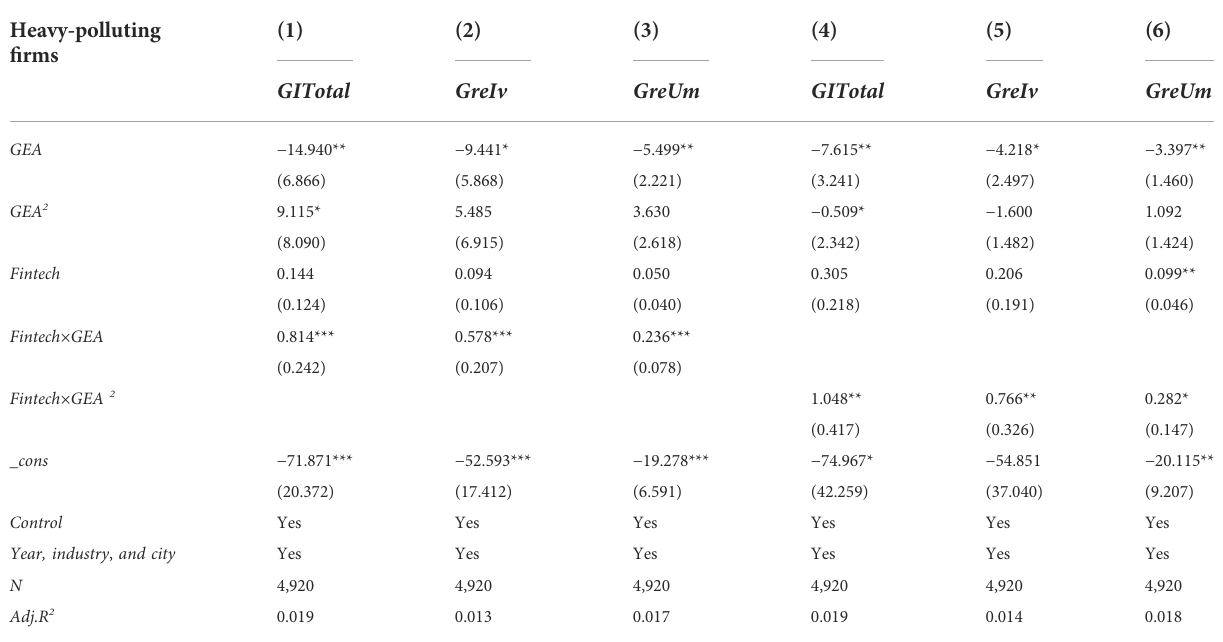
TABLE 3 Mediating effect